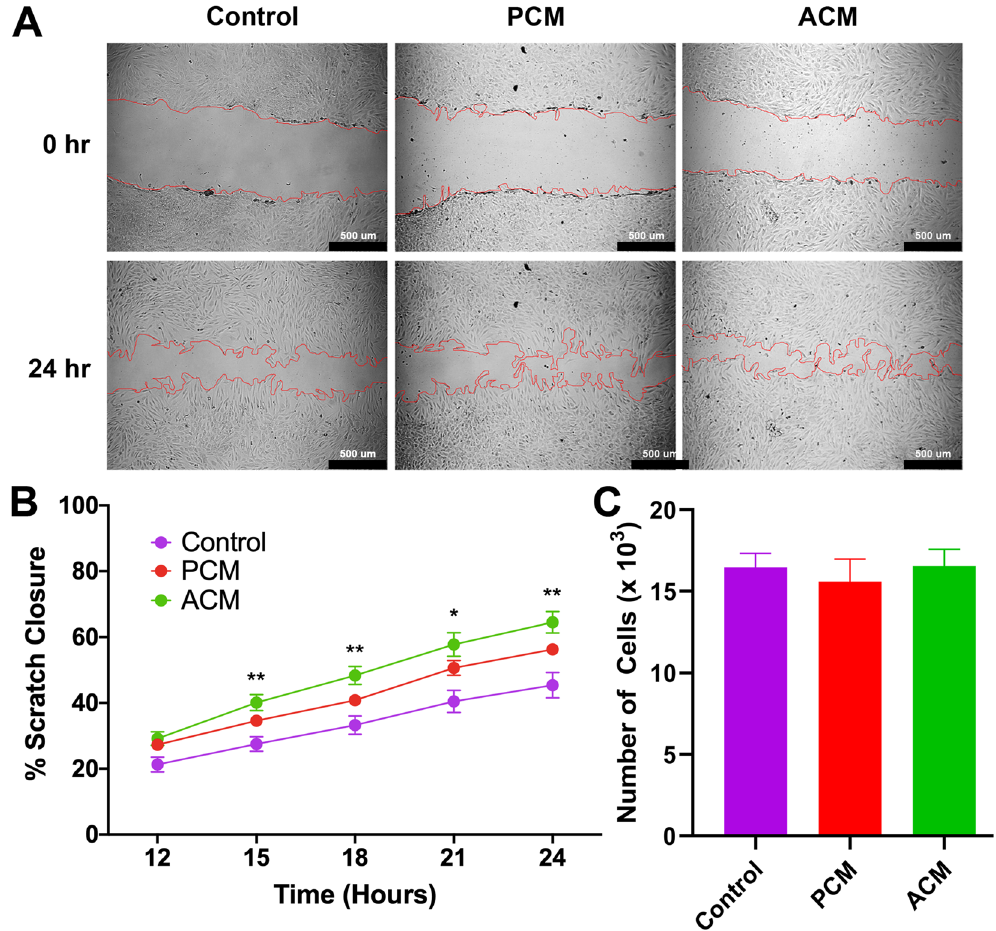
(PCM) and adipocyte conditioned medium (ACM), respectively. Visually identified scratch boundaries are demarcated in red. Scale bar is 500 µ m. ( B ) Quantification of percent scratch closure. Data is presented as mean ± SEM (n = 6 independent experiments with four samples per group). A two-way ANOVA with Dunnett multiple comparison tests at each time point indicate that fibroblasts exposed to ACM closed the gap significantly faster than fibroblasts in control medium ( ** p < 0.01, * p < 0.05). ( C) Cell number after 48